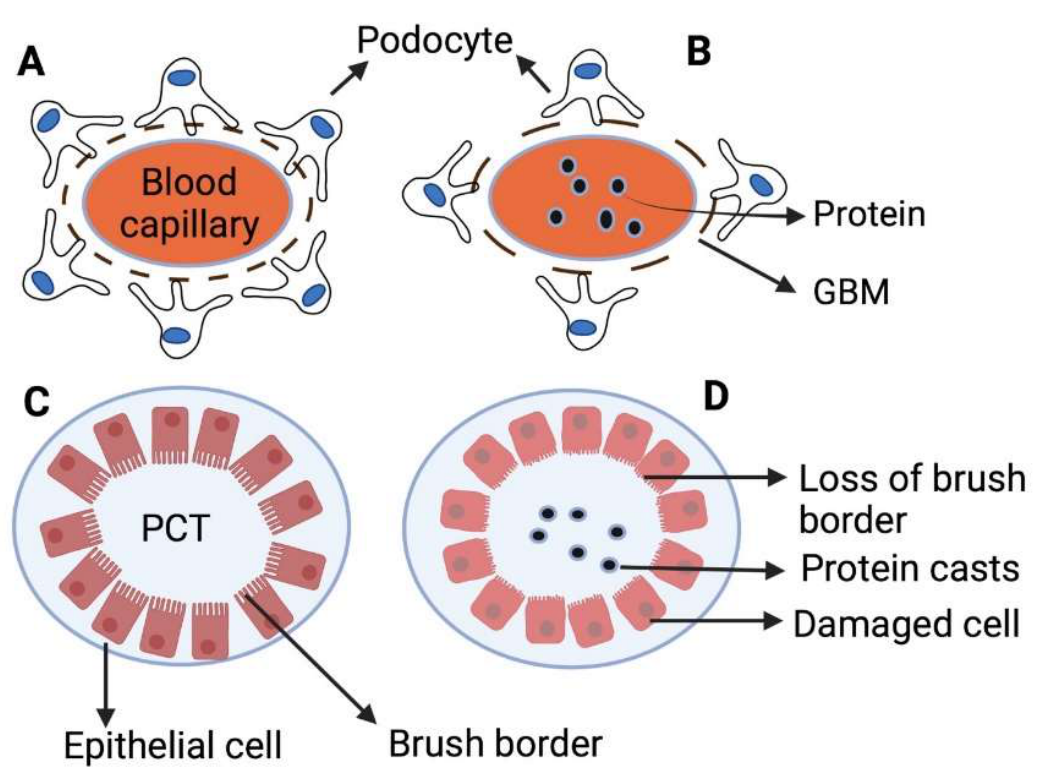
Figure 2. Schematic presentation of podocytes and proximal convoluted tubule. ( A ) healthy podocytes and glomerular basement membrane (GBM), ( B ) swollen proximal convoluted tubule (PCT) in injury condition explicit by the gaps in GBM, ( C ) healthy proximal convoluted tubule with good brush border epithelium, and ( D ) injured proximal convoluted tubule with lack of brush border.